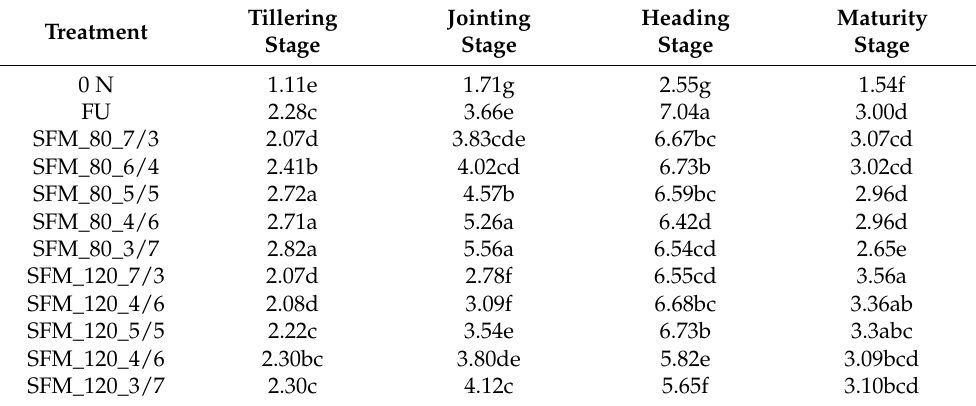
Table 4. Effects of different fertilization modes on the leaf area index (LAI) of rice. Treatment